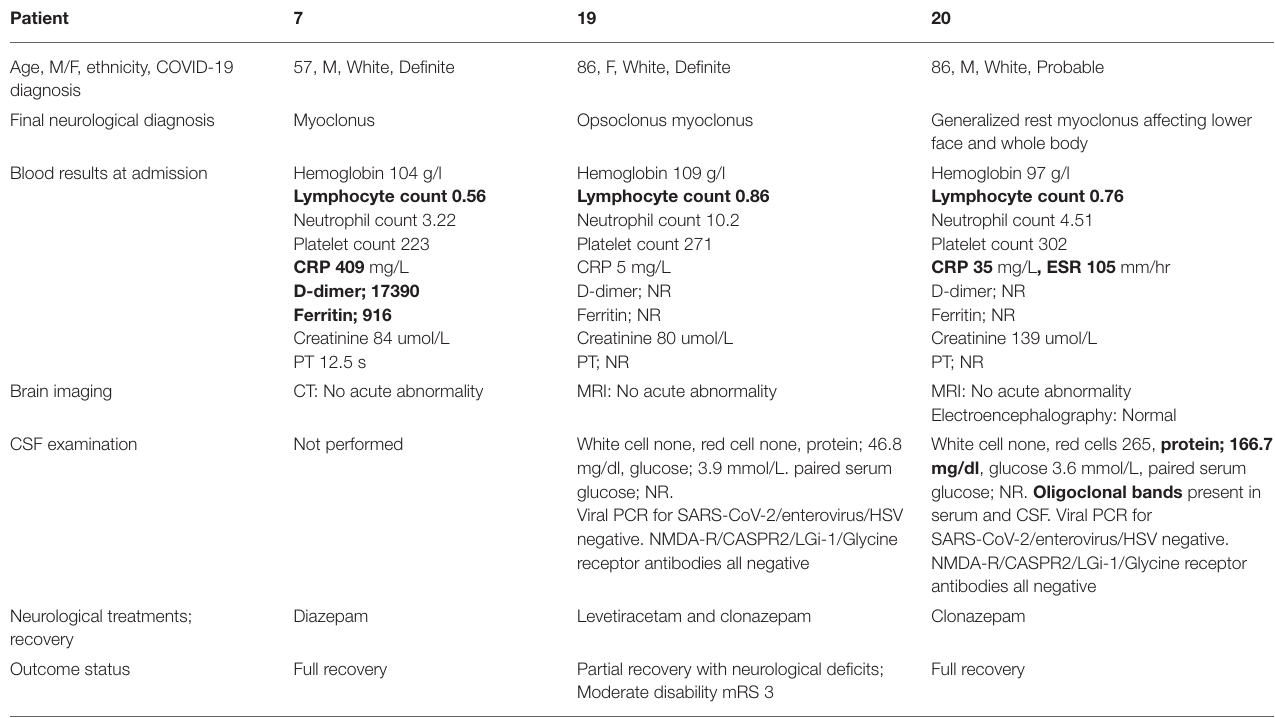
TABLE 3 | Three patients with movement disorders.